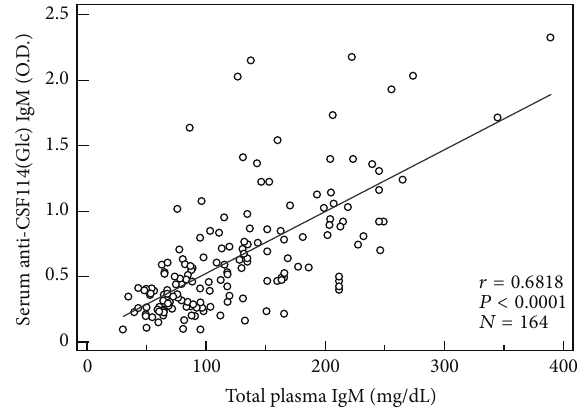
Figure 2: Correlation between anti-CSF114(Glc) serum IgM anti- body titers and total plasma IgM levels in RTT patients’